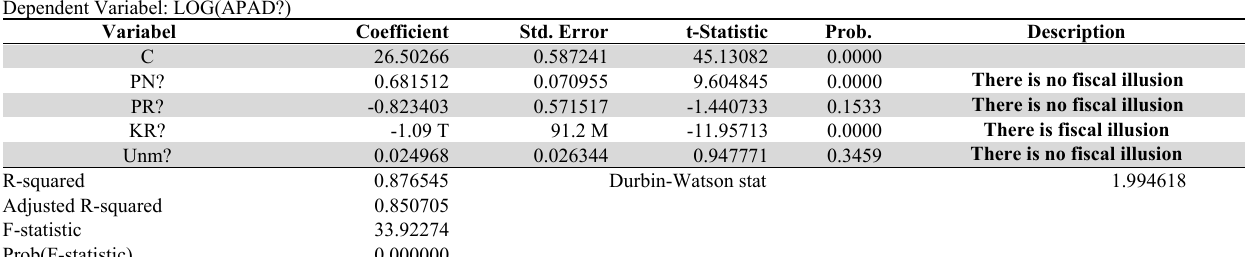
Results of Statistical Analysis of Eq. (3) Model